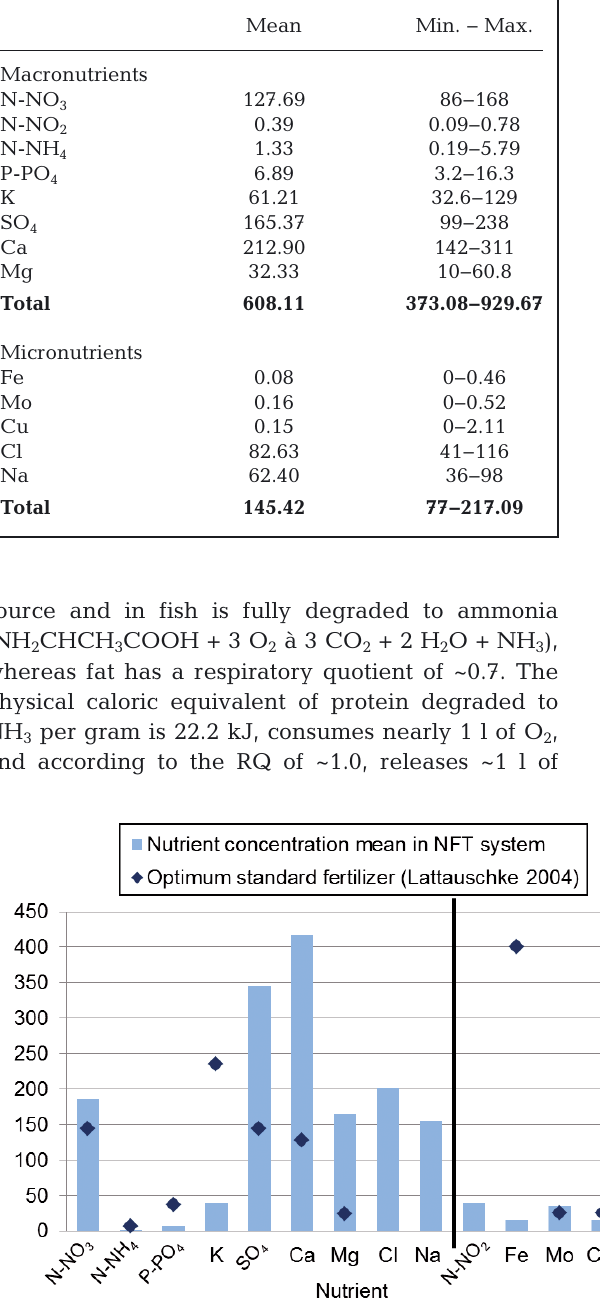
Fig. 8. Optimum standardized fertilizer for tomatoes Solanum lycopersicum ac- cording to Lattauschke (2004) (for nitrogen compounds, P, K, SO 4 , Ca, Mg, Fe, Mo, Cu) in comparison to means of macro- and micronutrients in the hydroponic unit (nutrient film technique, NFT) during the course of the experimental testing period revealing the grade of the optimum supply for tomato plants. The critical values for Na and Cl according to De Kreij et al. (1997) are 276 and 530 mg l −1 , respectively. Left (right) of vertical line: left-hand (right-hand) scale applies